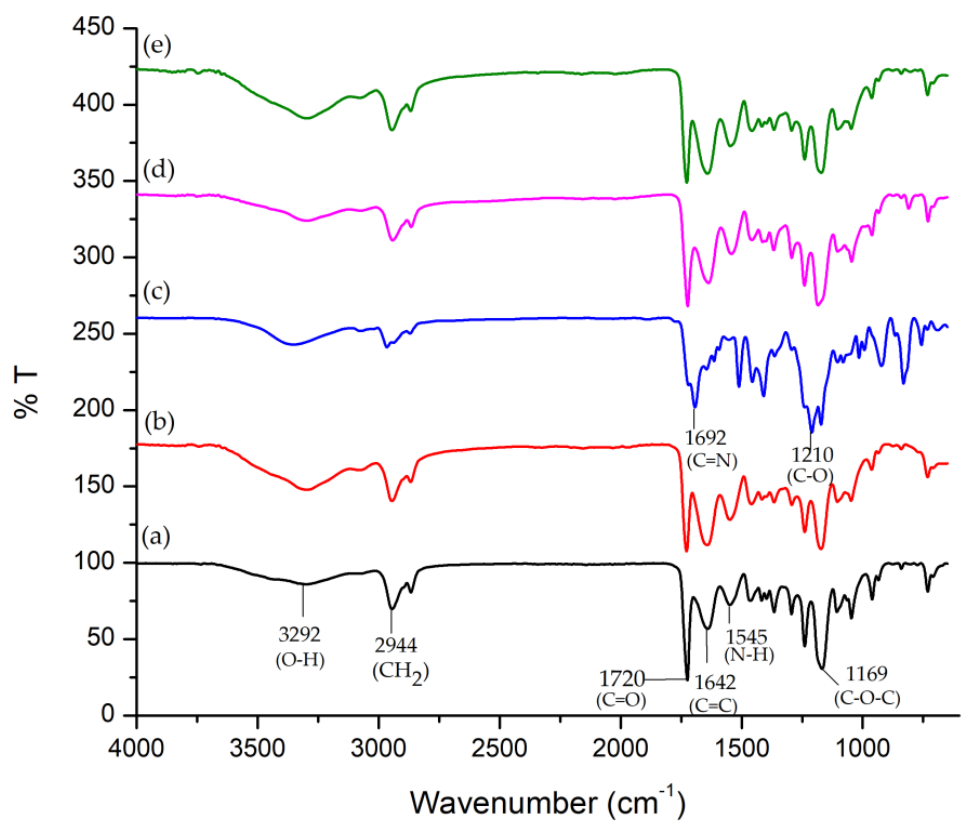
Figure 3. FTIR spectra of ( a ) PG; ( b ) PGO; ( c ) PGO-M1; ( d ) PGO-M2; and ( e ) PGO-M3 nanofibers. The wettability of the functionalized nanofibers was analyzed by water contact angle measurements (Figure 5). The water contact angle of the PGO nanofibers was 78 ± 1.4 ◦ , indicating high wettability due to the incorporation of gelatin and graphene oxide. The improved hydrophilicity of the nanofibers was mainly due to the incorporation of gelatin and graphene oxide containing -COOH and -OH groups, rendering the PGO nanofibers with high water affinity compared to pure PCL, which is hydrophobic in nature, with a water contact angle of 118 ± 6 ◦ [122,123]. The water contact angle of PGO-M1 was 72.6 ± 1.3 ◦ , which contained the polar and hydrophilic N-H group of diallylamine [124]. The PGO-M2 nanofibers functionalized with acrylic acid gave a water contact angle of 51.05 ± 1.9 ◦ . The -COOH group of acrylic acid contributed to its miscibility in water, giving the lowest wettability among the three samples [125]. However, the PGO nanofibers functionalized with M3 ( tert -butyl acrylate) displayed a water contact angle measurement of 127.03 ± 17.5 ◦ due to the hydrophobic surface provided by the tert -butyl acrylate